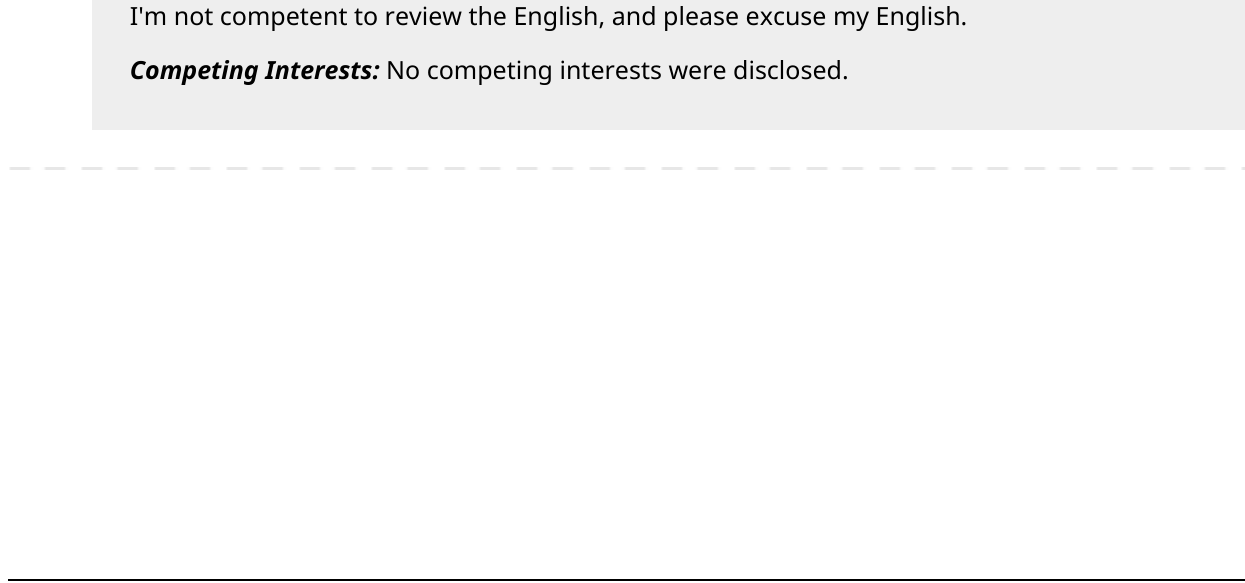
- Table 1, section 4.1.1: this should be explored before in my opinion (at step 3), when one decide of the data sharing